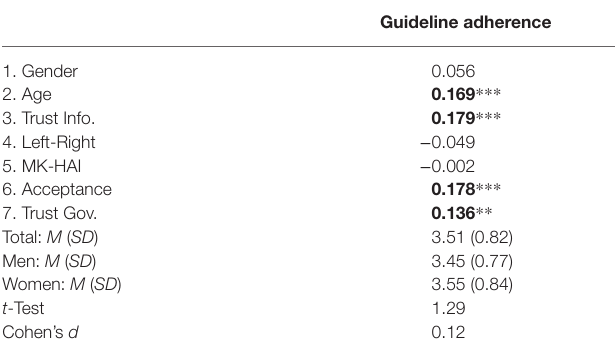
TABLE 10 | Means, SDs, and correlations for gender, age, trust in official information, political orientation, health anxiety, acceptance of the measures, and trust in the government with adherence to the social distancing guidelines in Study 3.